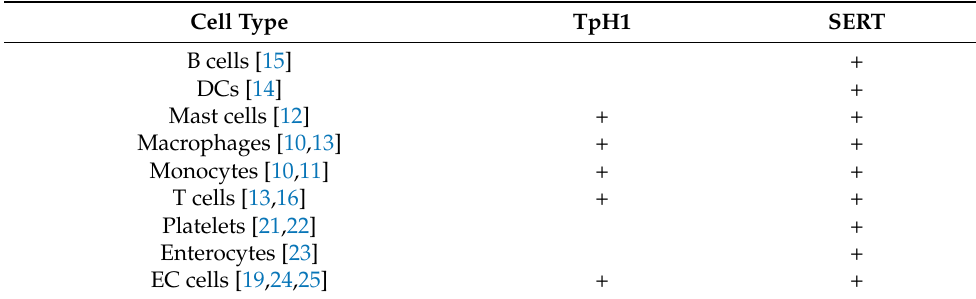
Table 1. Expression of TpH1 and SERT by immune and epithelial cells. Cell Type